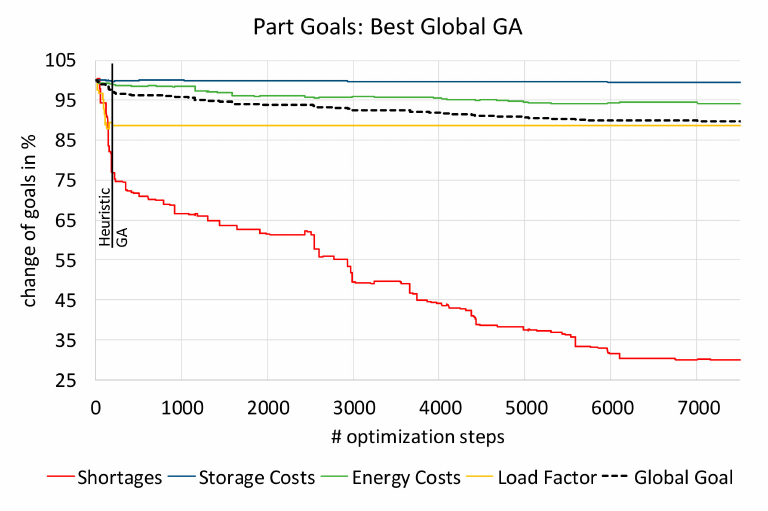
Figure 9. Part goal trends.